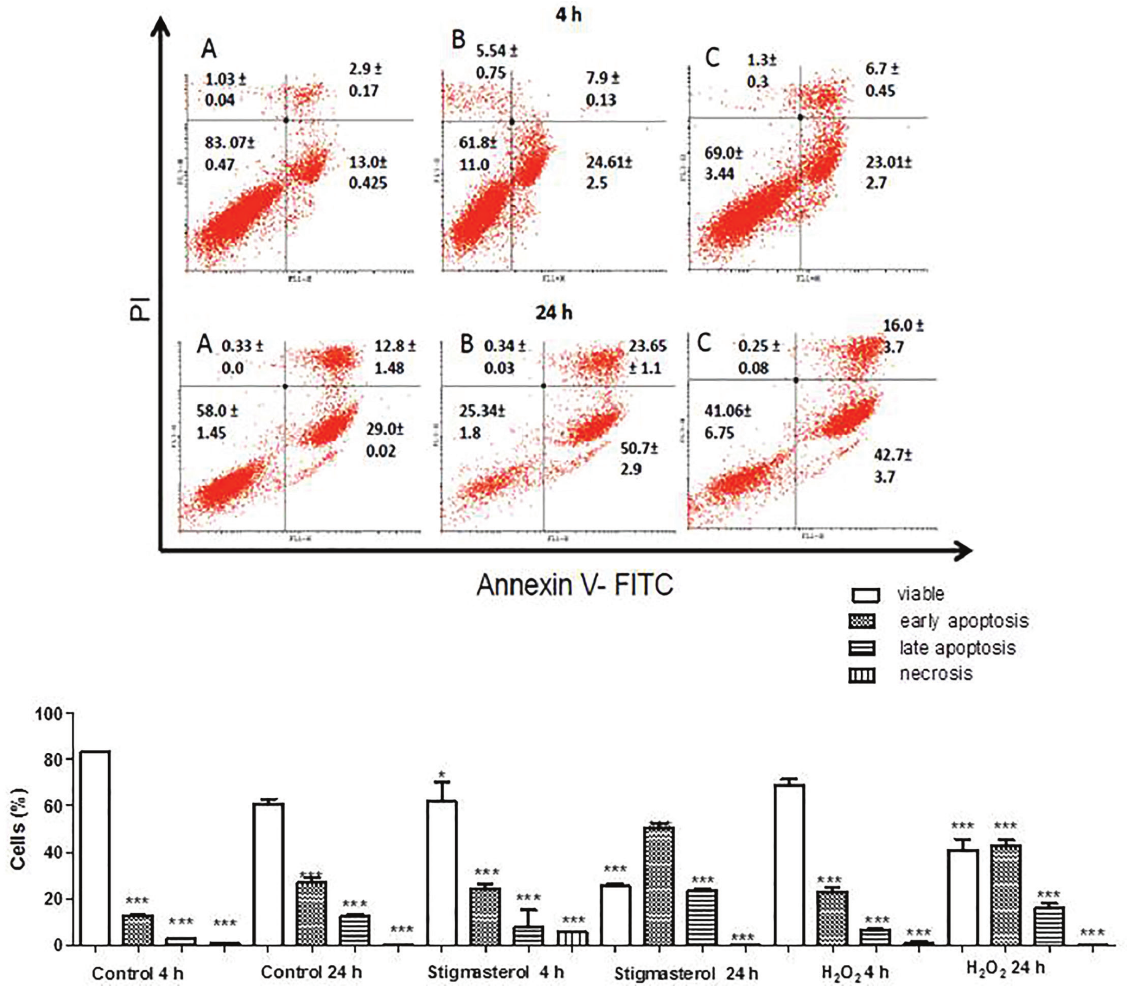
FIGURE 10 - Effects of Passiflora mucronata samples on K562 cell apoptosis. The annexin V+-FITC-PI labeling cytograms (I) of control ( A ), stigmasterol ( B ), H O ( C ) cultures in 4h and 24 h. Cells (10 6 .mL -1 ) were incubated with culture medium (control), 2 2 Apoptosis was investigated by flow cytometry analysis of cell shrinkage and Annexin V+-FITC labeling. The propidium iodide and Annexin V-FITC fluorescences were detected by the FL-3 and FL-1 channels, respectively. The graphic (II) represents the results expressed as average ± SD of two independent experiments. [*] p<0.05 and [***]